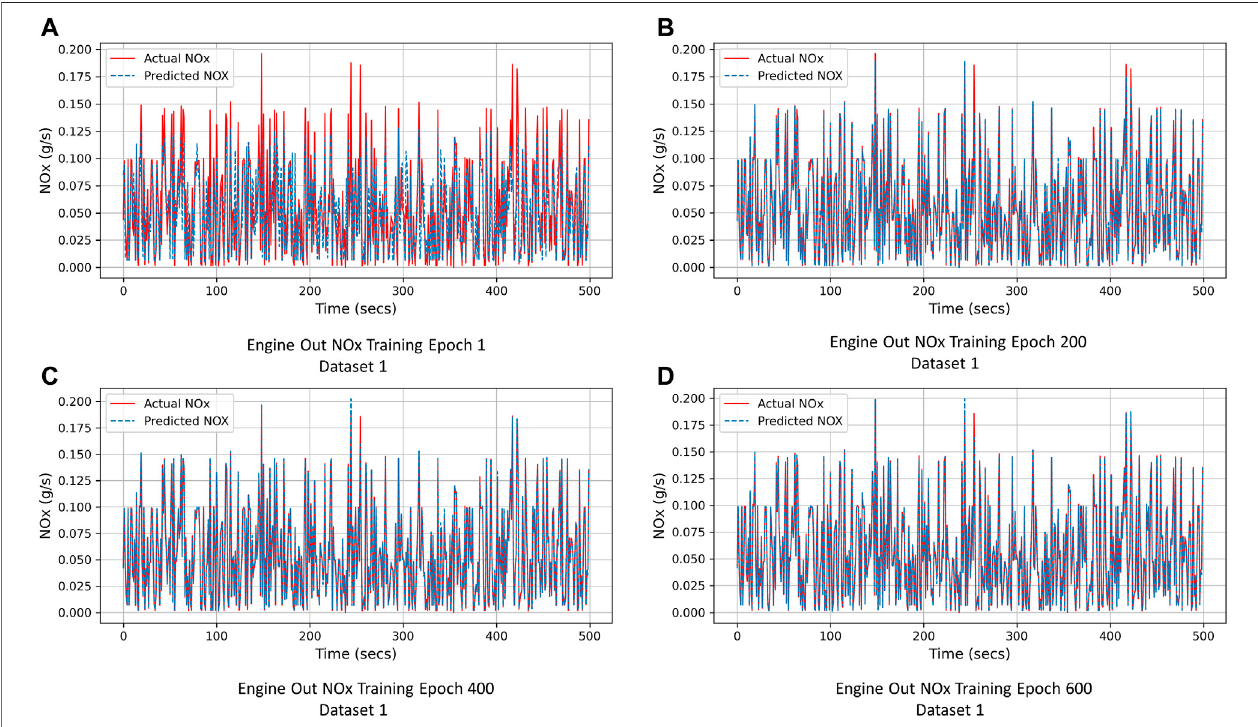
FIGURE 6 | Improvement of instantaneous NO x prediction over DNN training (Engine-Out NO x model Dataset 1). (A) Engine Out NOx Training Epoch 1 Dataset 1. (B) Engine Out NOx Training Epoch 200 Dataset 1. (C) Engine Out NOx Training Epoch 400 Dataset 1. (D) Engine Out NOx Training Epoch 600 Dataset